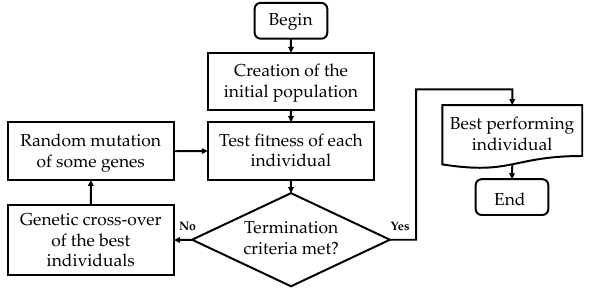
Figure 1. The genetic algorithm process as a block diagram.